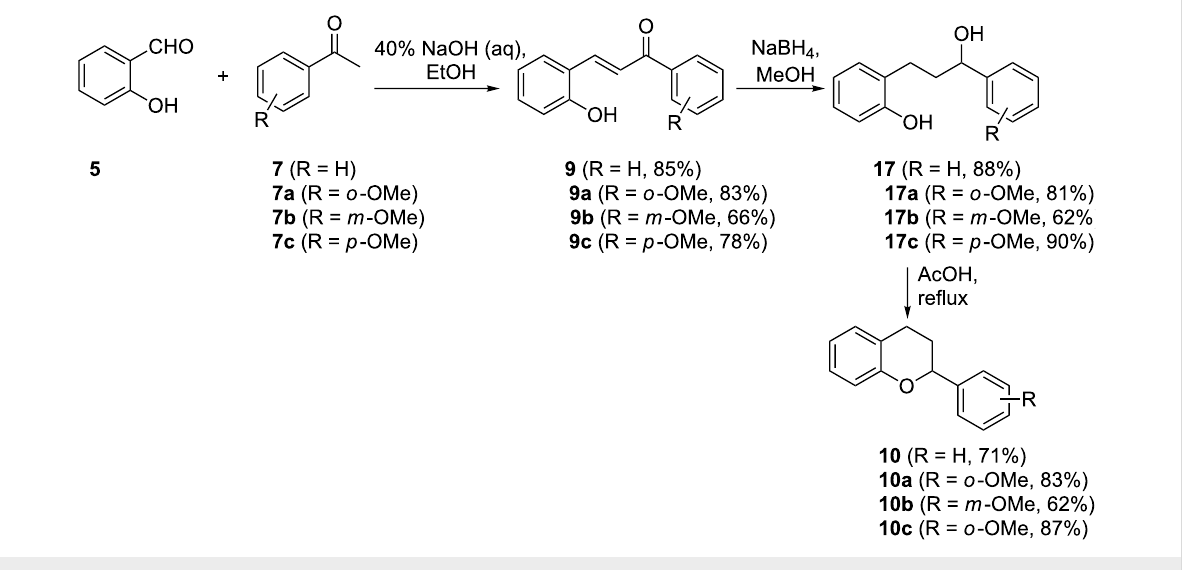
Scheme 4: Synthesis of flavans of type 10 by Mazimba and co-workers.